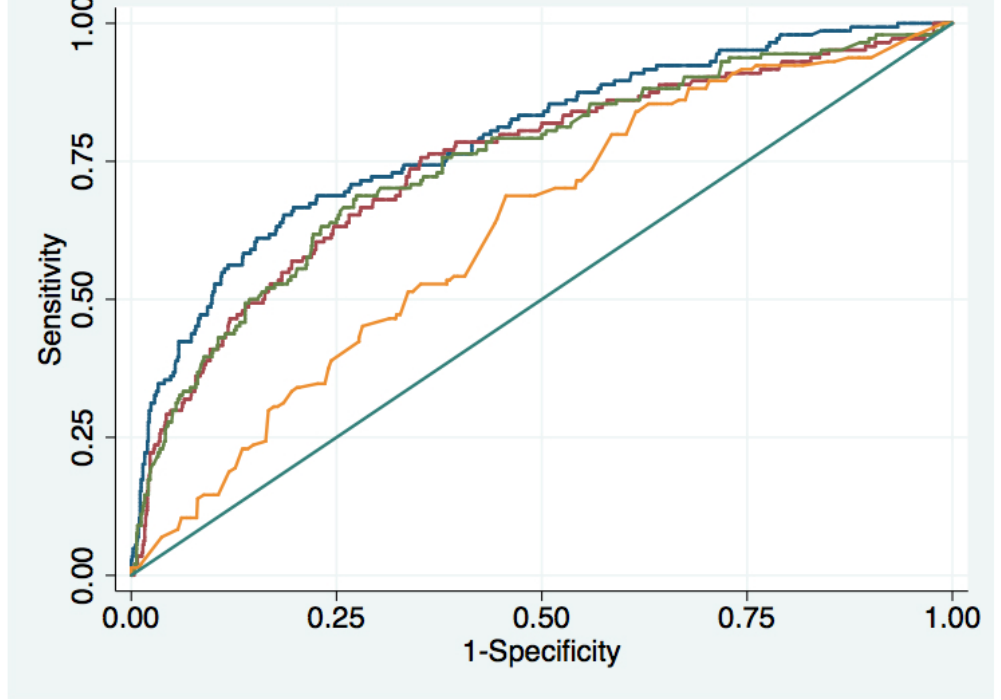
Figure 4. Receiver Operator Characteristic (ROC) curves for models predicting patient reports of being bedbound due to mental health